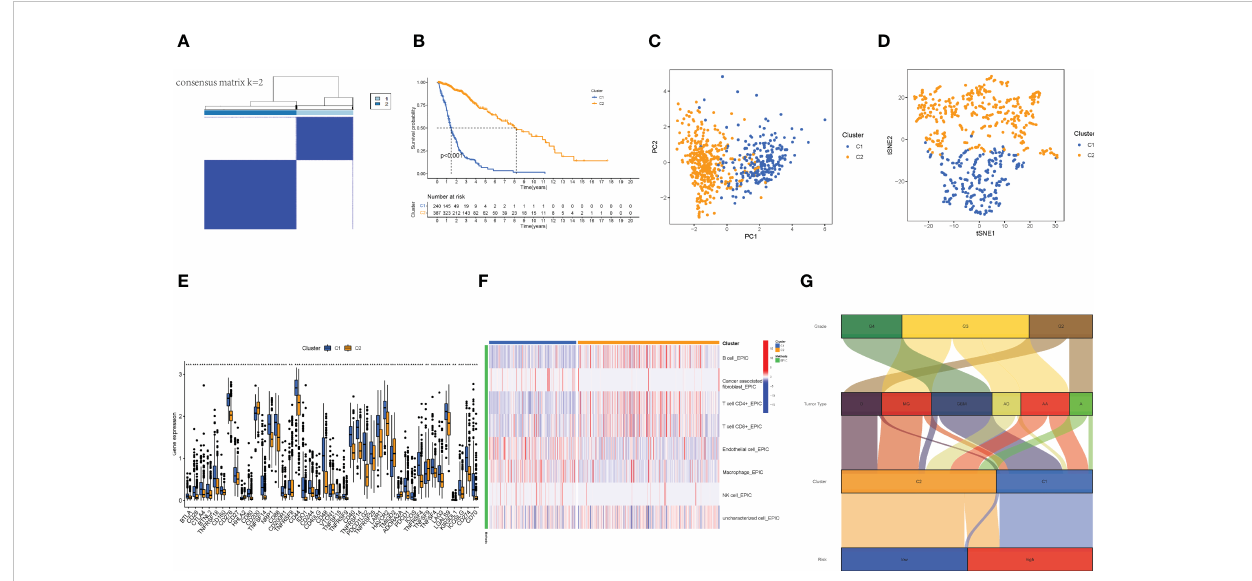
FIGURE 7 The distinguish between Cold and Hot tumors. (A) Patients divided into two clusters by Consensus Cluster Plus. (B) The survival of different clusters (p< 0.001). (C, D) The PCA and t-SNE of cluster 1 and 2, respectively. (E) The difference of 43 checkpoints expression in clusters. (F) The immune in fi ltration difference between clusters. (G) The Sankey plot of grade, tumor type, clusters, and risk groups.